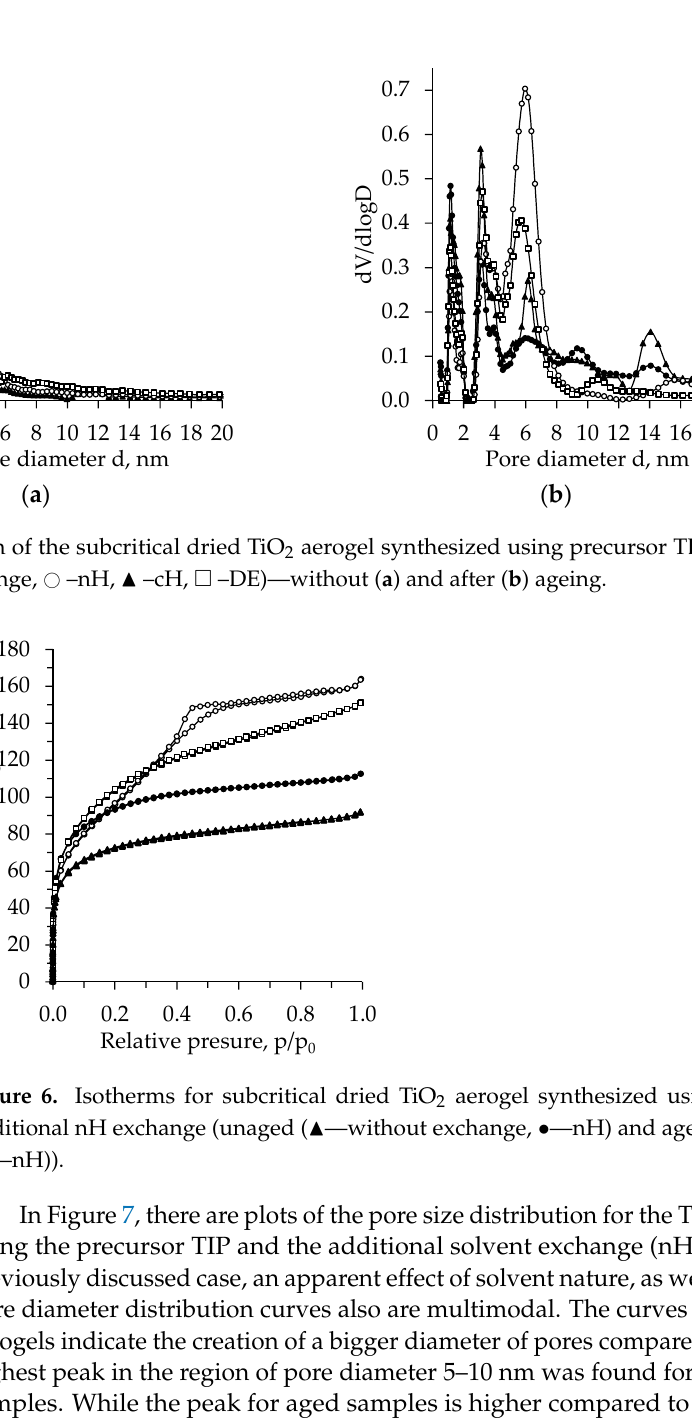
Figure 6. Isotherms for subcritical dried TiO 2 aerogel synthesized using precursor TBOT and addi- tional nH exchange (unaged ( ▲ –without exchange,  –nH) and aged (  –without exchange,  – nH)).